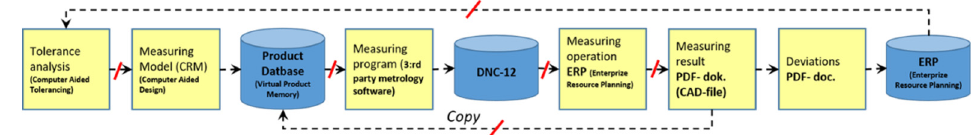
Figure 17. Holistic illustration and activity model of the Saab dimensional management and metrology data and information process.